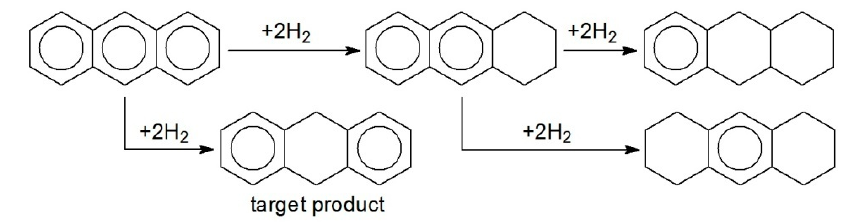
Figure 4. Simplified scheme of selective hydrogenation of NL to TL.